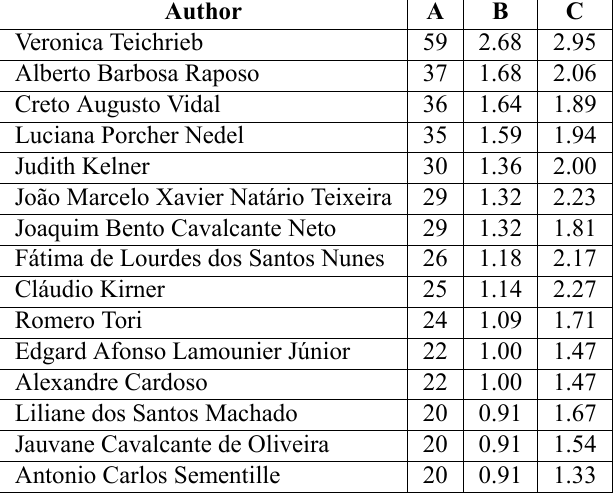
Table 4. Most active SVR authors. Column A represents the total amount of papers published by that author. Column B illustrates the average number of published papers considering all 22 years of events. Column C is similar to B, but calculates the mean consider- ing only the years in which the author had some paper